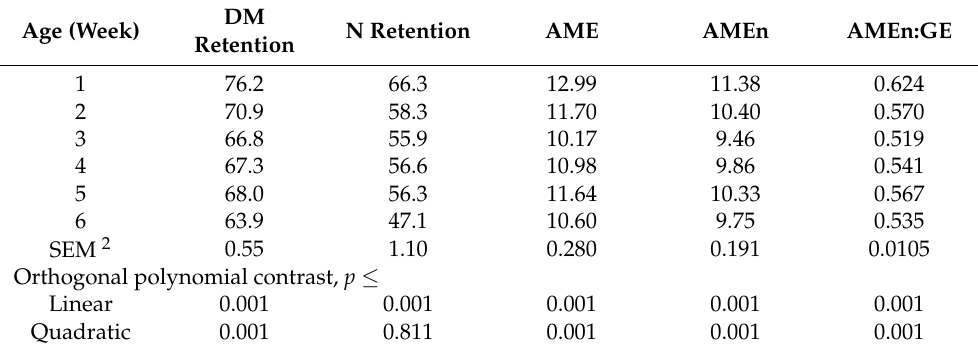
Table 3. Influence of broiler age on the retention (% of intake) of dry matter (DM) and nitrogen (N), and the ratio between AMEn and gross energy (AMEn:GE; MJ/MJ) of soybean meal 1